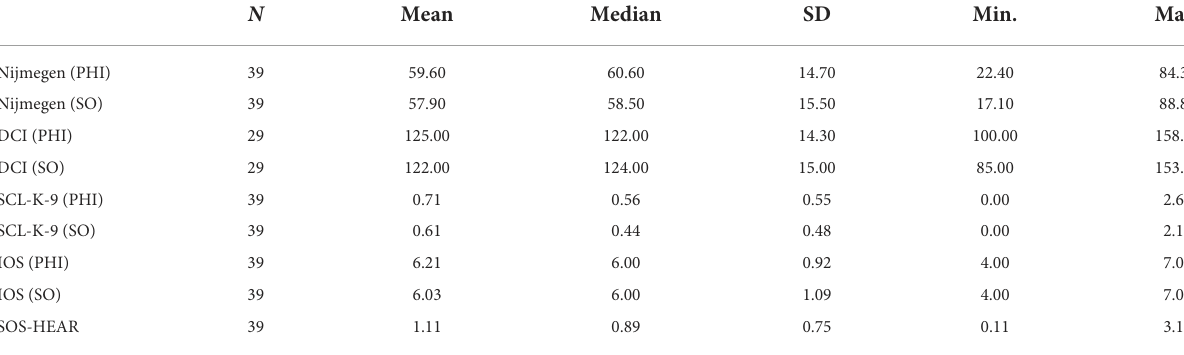
TABLE 4 Results of the different questionnaires